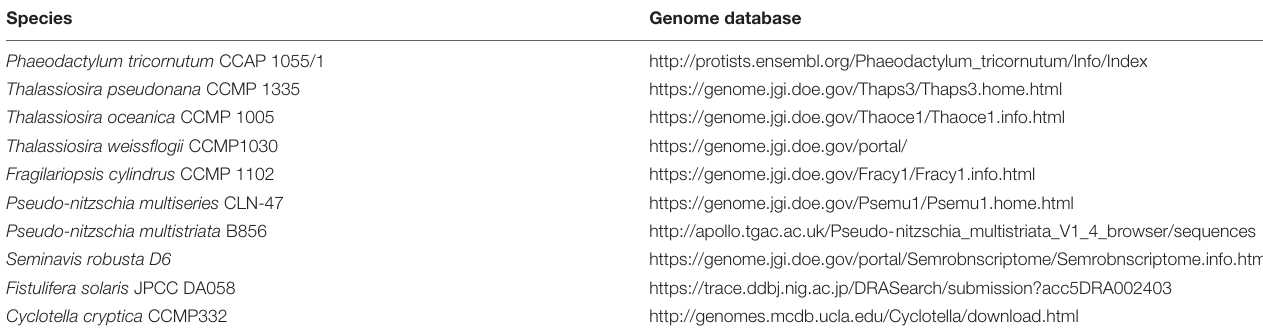
TABLE 4 | Sequence Database of different diatoms